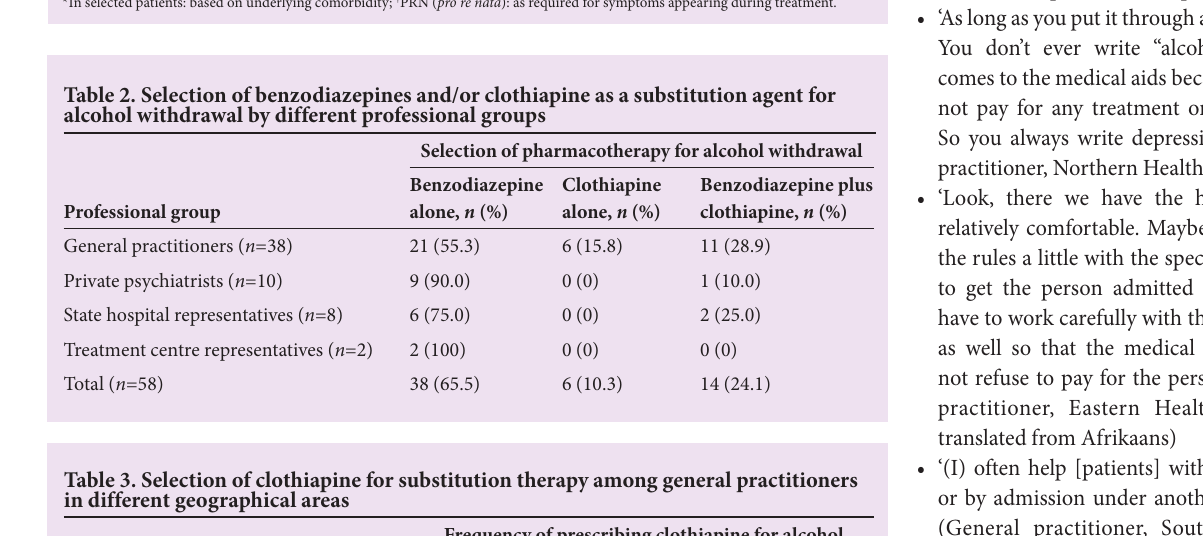
Geographical area